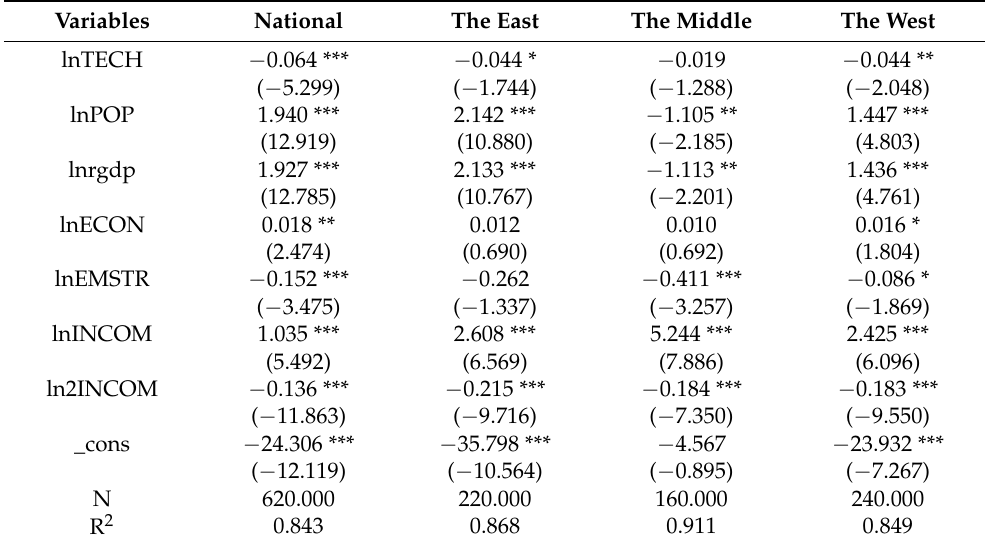
Table 6. The impact of technological innovation on carbon